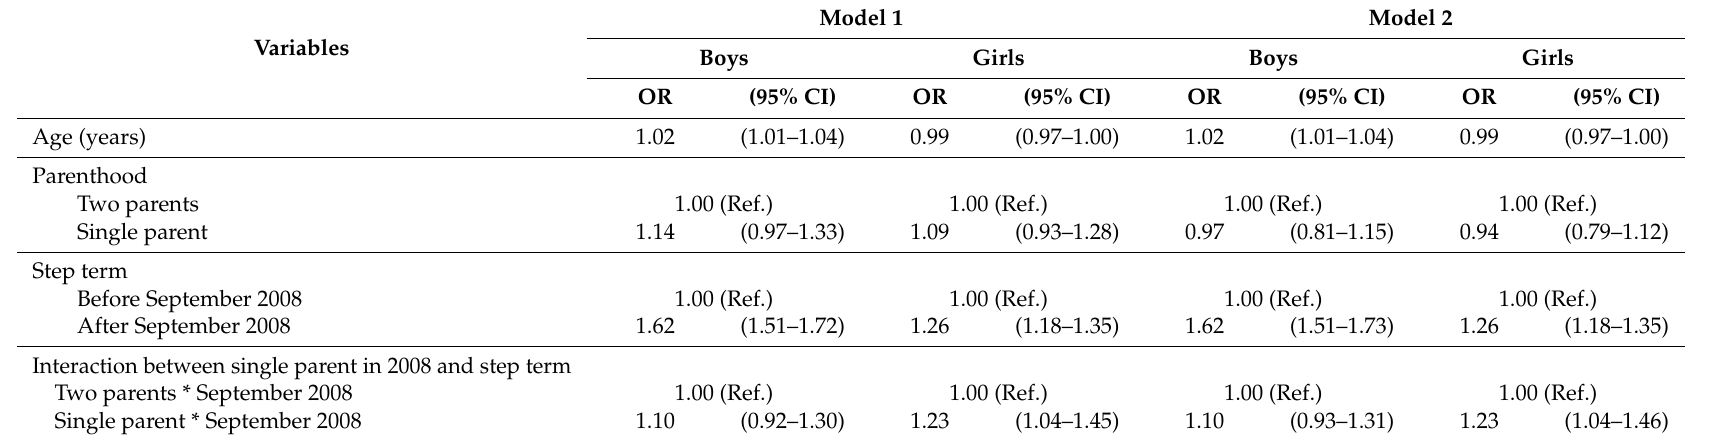
Table 2. Odds ratio (OR) and 95% confidence interval (CI) for risk of overweight relative to normal weight by